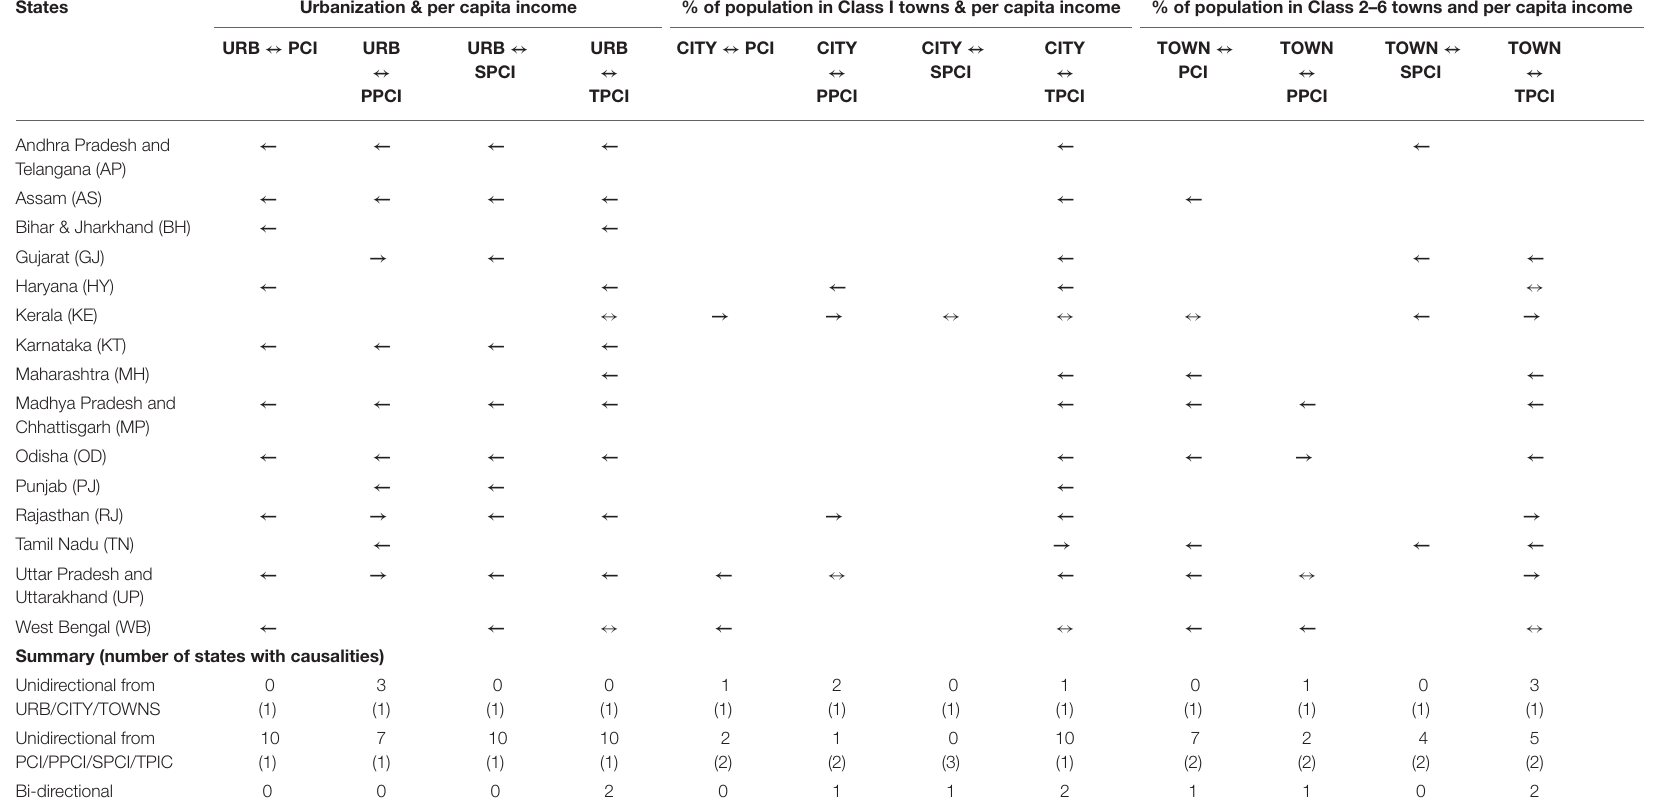
The arrows show the directions of Granger causalities significant at the 5% or above levels. Abbreviations of states are given after the names of states. Numbers in parentheses are the lags